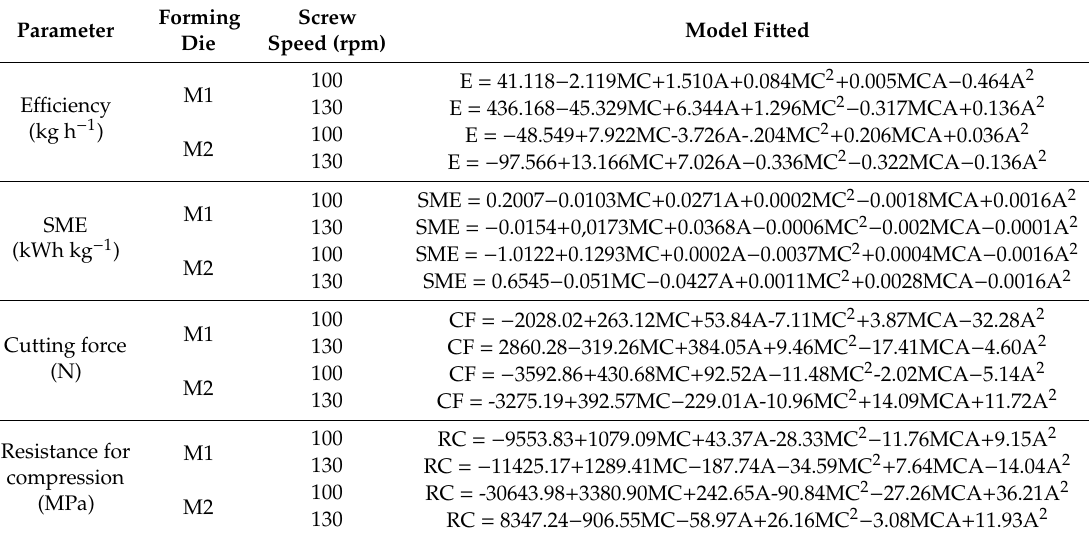
M1—circular die; M2—ring die; MC—moisture content; A—additive